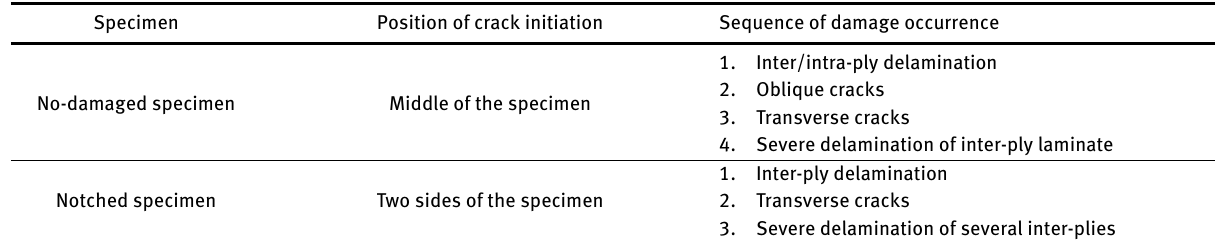
Table 5: Differences in damage evolution behaviour between no-damaged and notched laminates